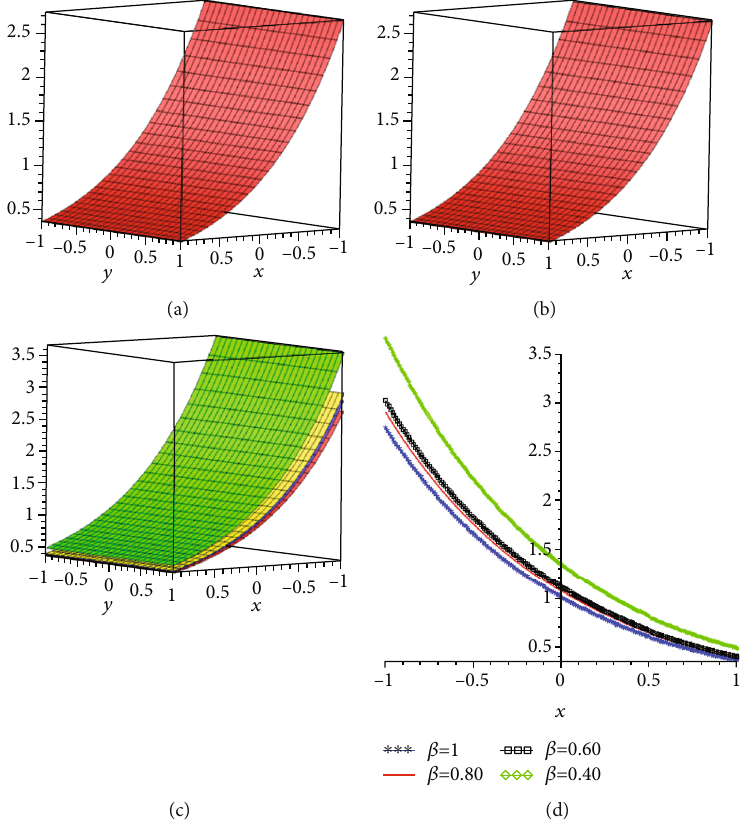
Figure 1: Nature of the exact and proposed technique results of example